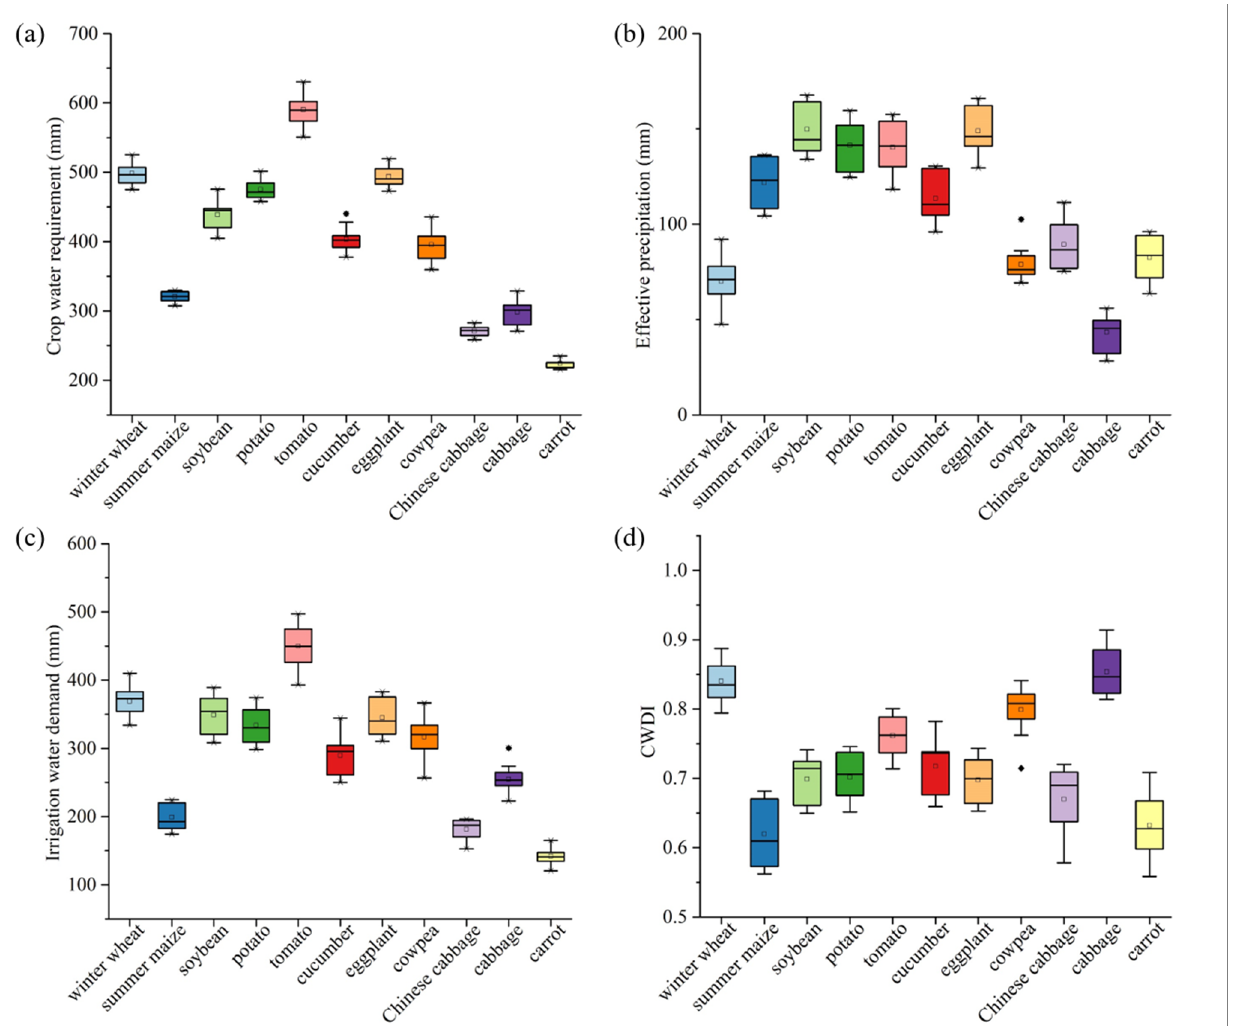
Figure 2. Annual averages of crop water requirement ( a ), effective precipitation ( b ), irrigation water demand ( c ) and water deficit index ( d ) of different crops in Hebei Province from 2007 to 2017.